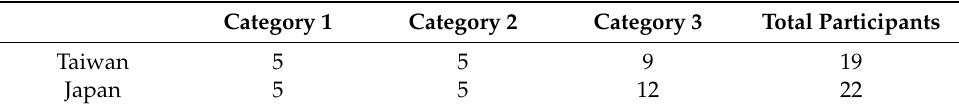
Table 12. Preferences of